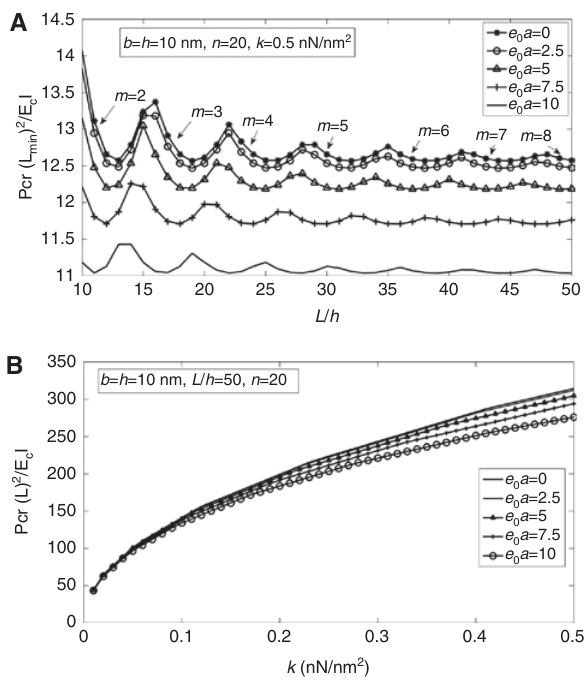
Figure 1: Effect of (A) aspect ratio and (B) stiffness of elastic foun- dation on the buckling force of FG nanobeams.